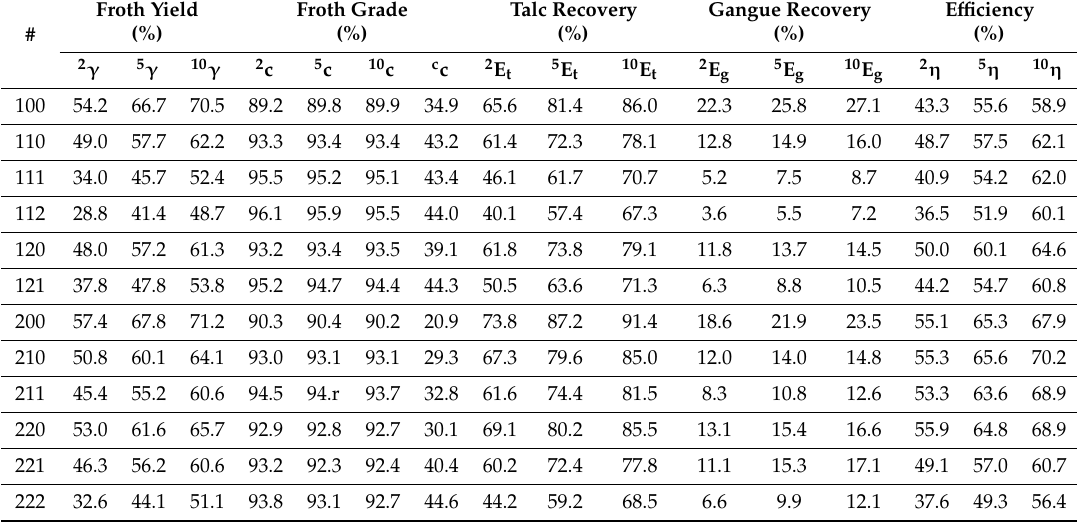
Table 3. Results of the laboratory froth flotation tests.